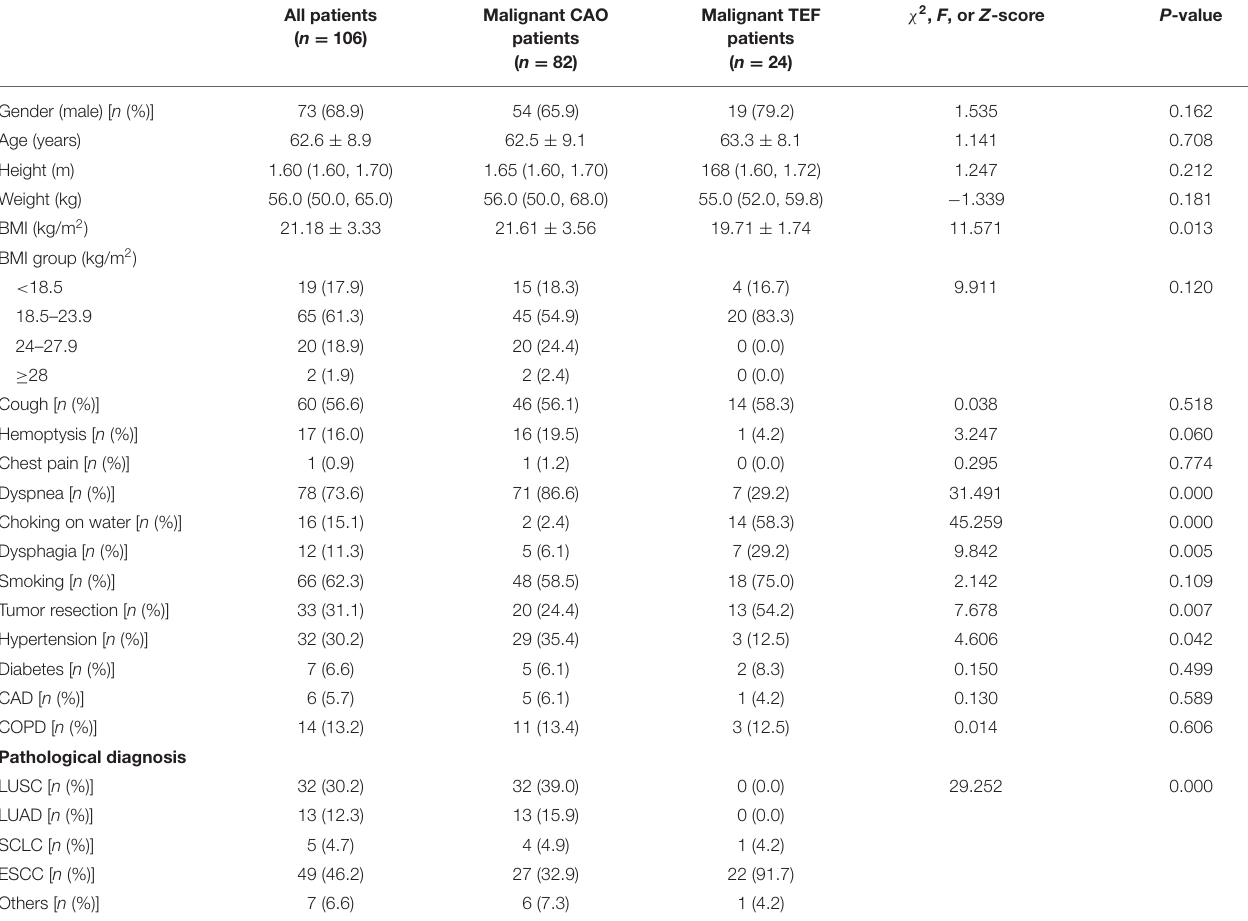
TABLE 1 | Demographic features and clinical characteristics between malignant CAO and malignant TEF patients.